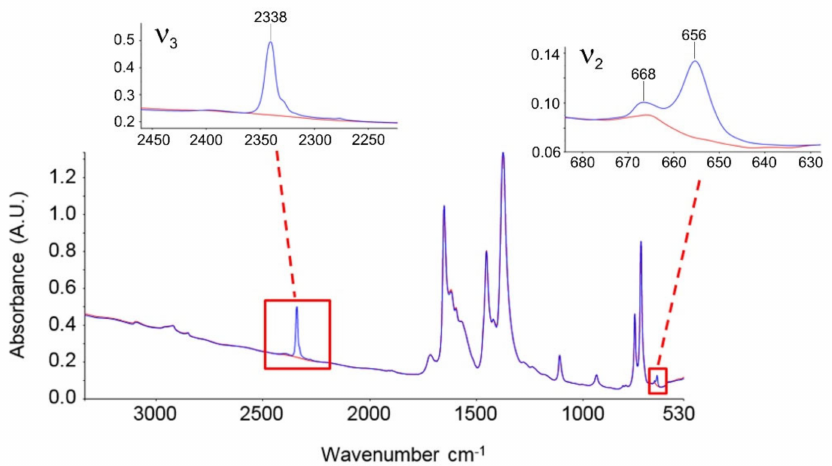
Figure 2. Absorbance spectra of activated CuBTC (red trace) and CuBTC equilibrated at 150 Torr, 35 ◦ C. Insets display the ν 3 and ν 2 bands of sorbed CO 2